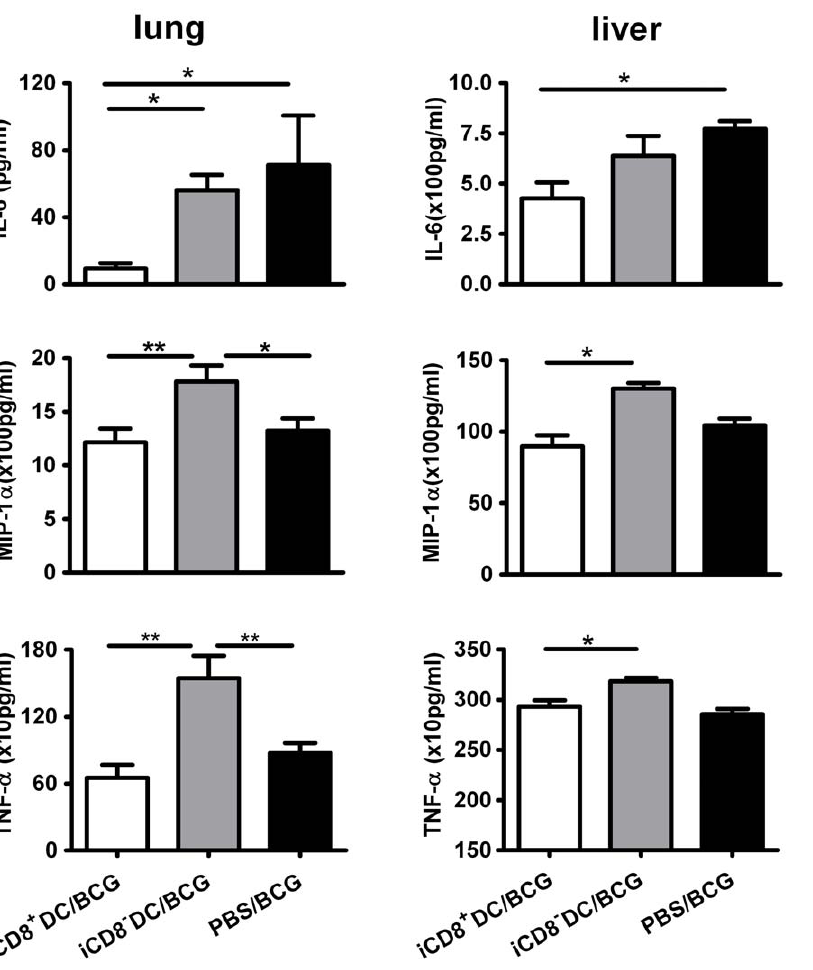
Figure 6. Pro-inflammatory cytokine/chemokine levels in local tissues in mice treated with different DC subsets following challenge infection. The mice were treated as described in the legend to Fig. 4 and the levels of IL-6, MIP-1 a and TNF- a proteins in the homogenates of lung and liver tissues were measure by ELISA.